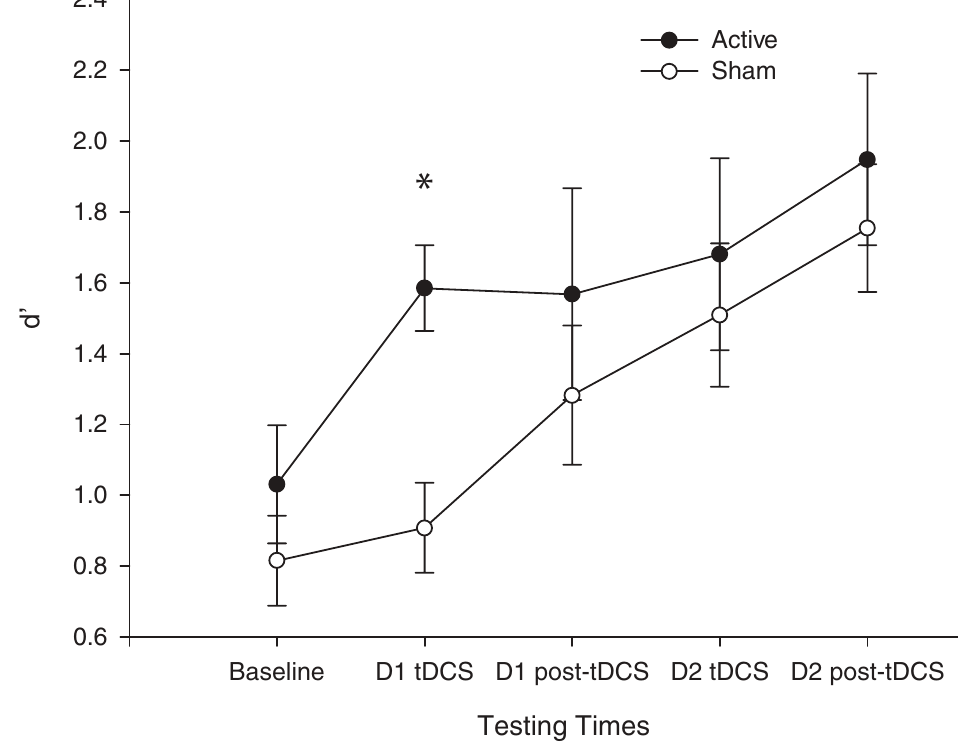
Figure 3. 3-back d' performance (mean values) across testing times and days. The active stimulation group always performed better than the sham group but only statistically significantly so during stimulation on day 1 (D1 tDCS), denoted by an asterisk (*). Baseline performance did not differ between the groups but was included in the model as a covariate. Error bars represent ±1 standard error of the